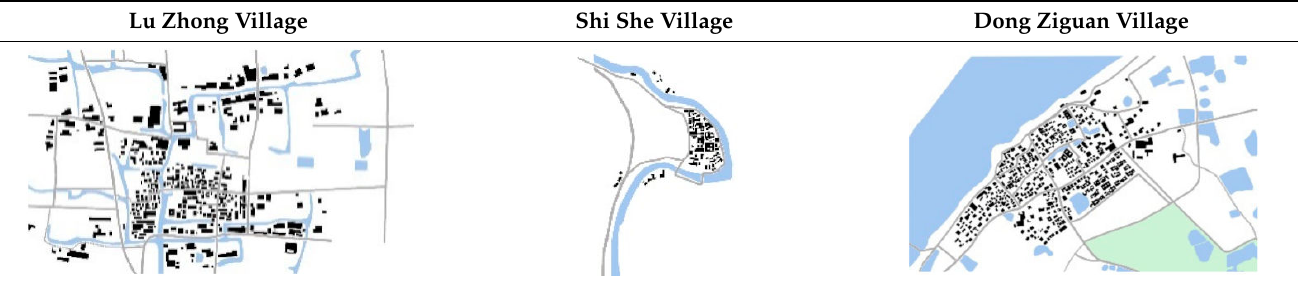
Table A1. The Survey and Draw Image of Jiangnan Traditional Villages Used for Model Visualization in the Article: Edited by